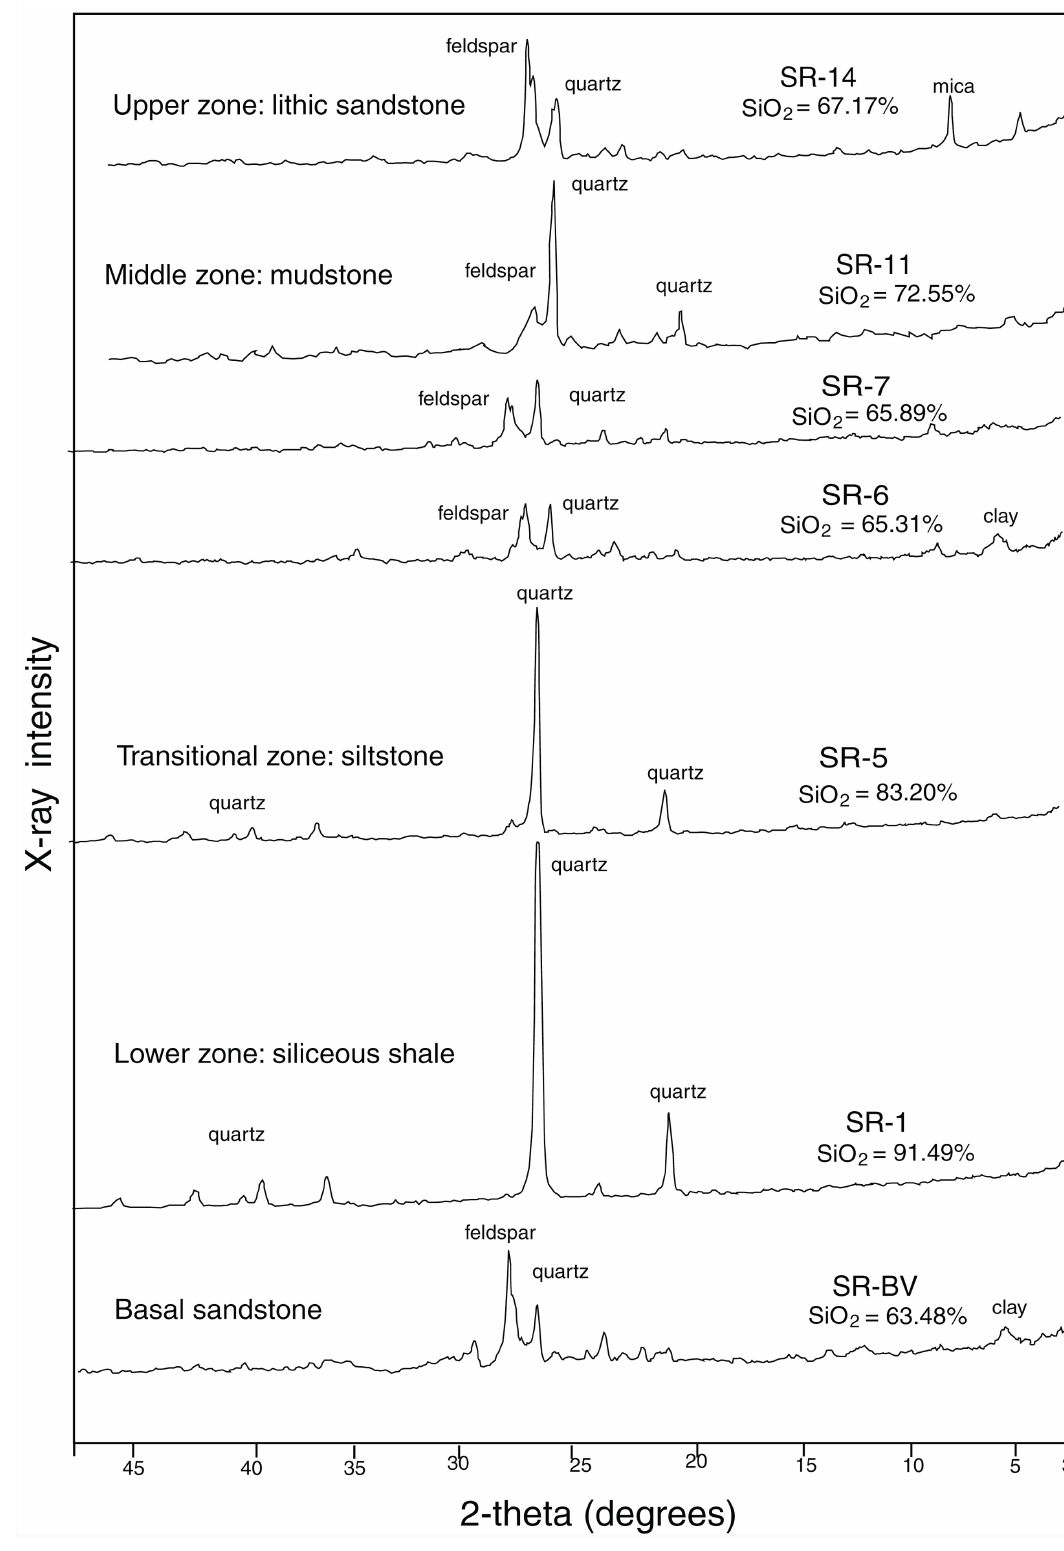
Figure 7. X-ray diffraction patterns for Boot Hill